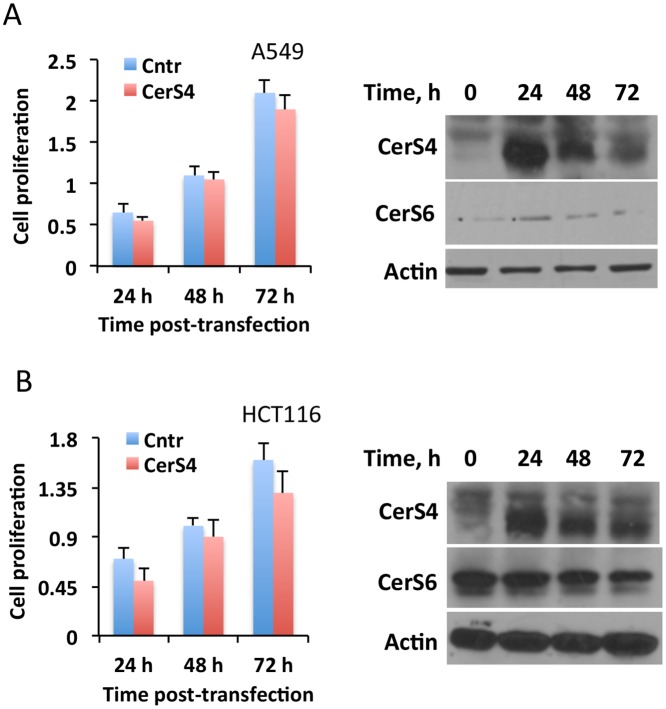
The effect of CerS 4 transient expression on cancer cell lines highly sensitive to MTX.Transient expression of CerS4 in A549 or HCT116 cells does not inhibit cellular proliferation (MTT assay). Data are average of two independent experiments, each done in quadruplicates with error bars representing SD. Differences between control and CerS4-expressing cells were not statistically significant (p>0.1) in both panel A and panel B. Insets show levels of CerS4 and CerS6 in the cells after transient expression of CerS4.